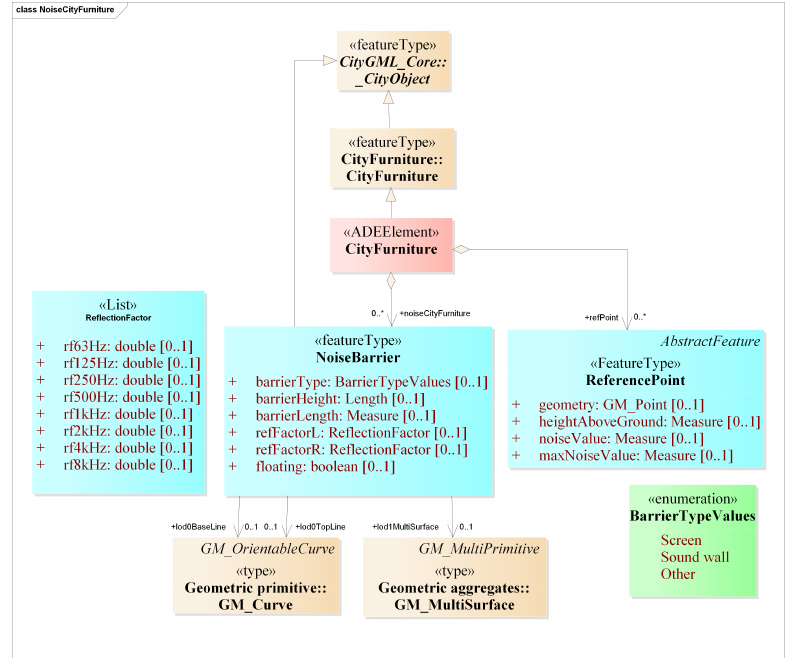
Figure 8. UML model for the noise barriers and reference points modeled in